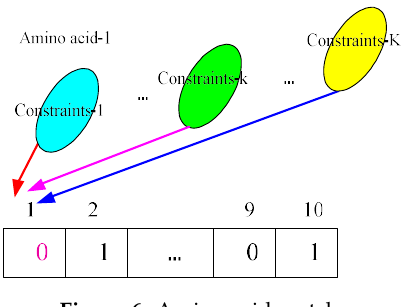
Figure 6. Amino acid match.